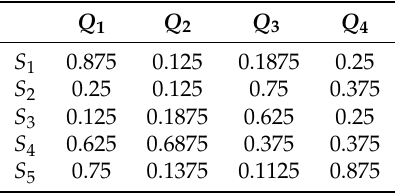
Table 3. Linguistic values of the objective function corresponding to robot